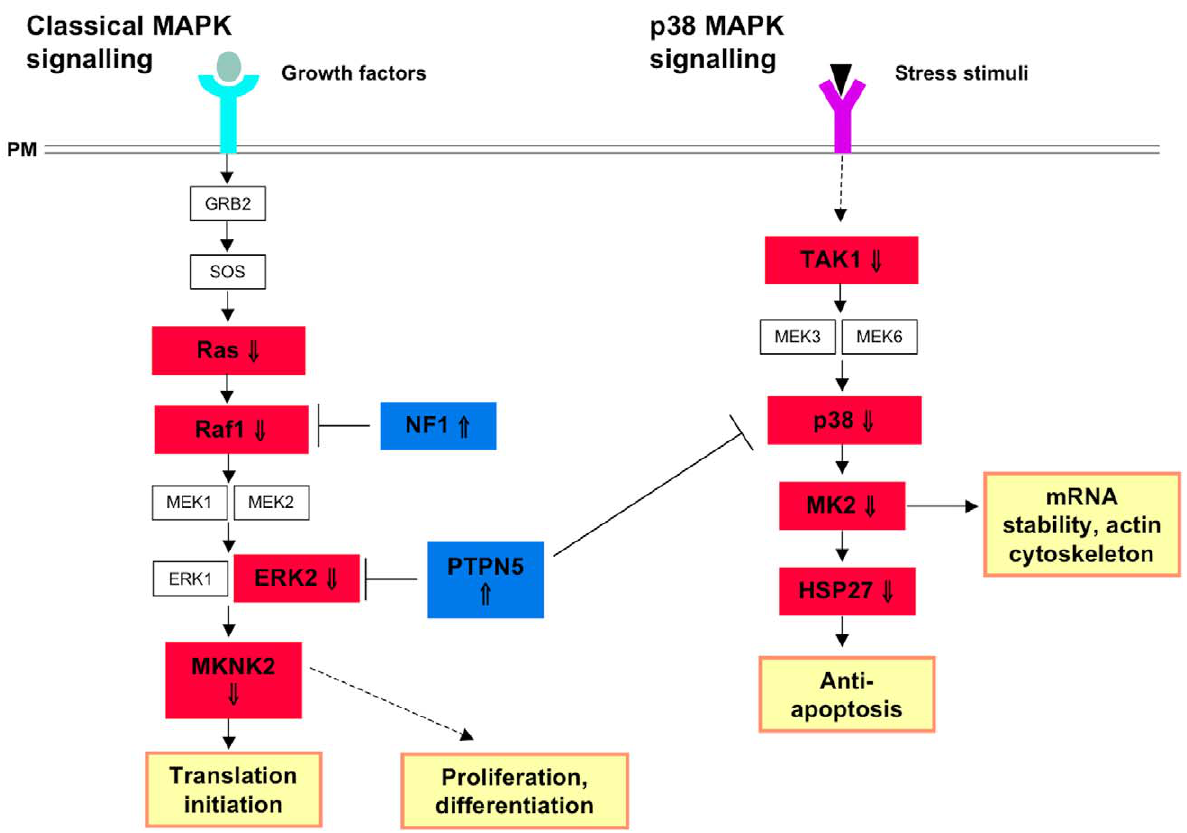
Figure 4. Defects in MAPK signalling as a result of mutations in CHMP2B . There are two main pathways through which MAP kinases signal: the classical MAPK pathway and the p38 MAP kinase pathway. In the classical signalling pathway, ligand binding results in receptor activation, which in turns leads to the activation of GRB2 and SOS. SOS catalyses the substitution of GDP for GTP on RAS ( Y ), which then activates RAF1 ( Y ). RAF1 subsequently phosphorylates MEK1/2, which in turn activate ERK1 and ERK2 ( Y ). The ERK proteins activate MKNK2 ( Y ), which is directly responsible for activation of proteins required for translation initiation. Downregulation of multiple core signalling components in combination with upregulation of the inhibitors, NF1 and PTPN5 predicts inability of the cell’s basal response to growth factors. The p38 MAPK pathway is a signalling cascade that is distinct, but not exclusive from the classical MAPK signalling pathway. As with the classical MAPK pathway, multiple elements of the pathway are downregulated: TAK1( Y ), p38 ( Y ), MK2 ( Y ) and HSP27 ( Y ) which may result in a decrease in mRNA stability and the cell’s anti-apoptotic response. (PM=plasma membrane) doi:10.1371/journal.pone.0009872.g004 PLoS ONE |